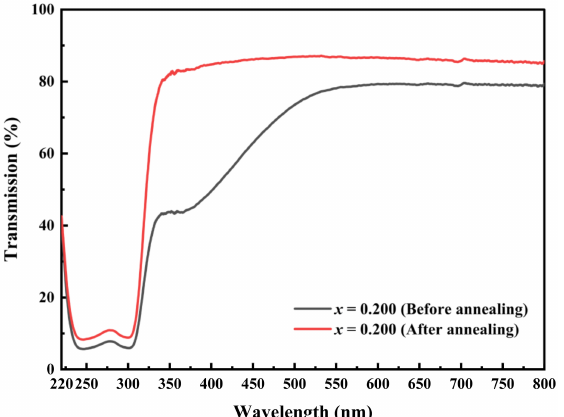
Figure 8. Transmission spectra of (ZrO 2 ) 92 (Y 2 O 3 ) 7.800 (Tb 4 O 7 ) 0.200 crystals before and after annealing at 1500 ◦ C in a H 2 /Ar